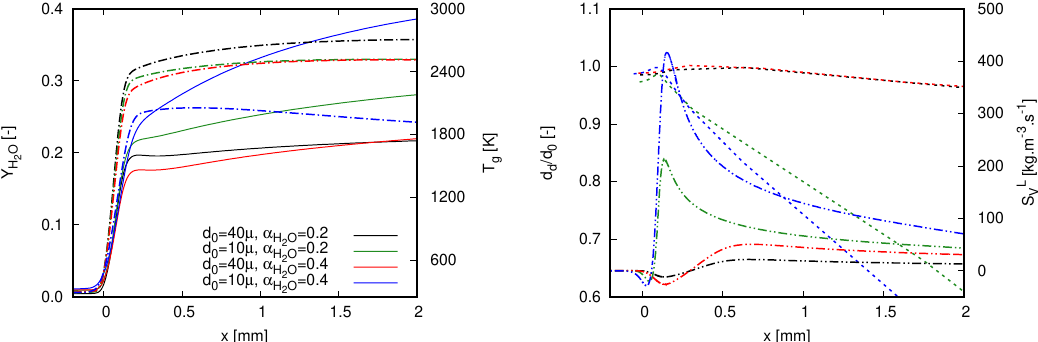
Figure 6. Characteristics of different quantities along stoichiometric flames for both investigated dilution fractions and droplet initial diameters. Simulations were achieved with GRI 3.0. ( left ) Water mass fraction Y H temperature T g (dash-dot line); and ( right ) normalized droplet diameter d d / d 0 (dashed line) and source term of vapor S L (dash-dot-dot